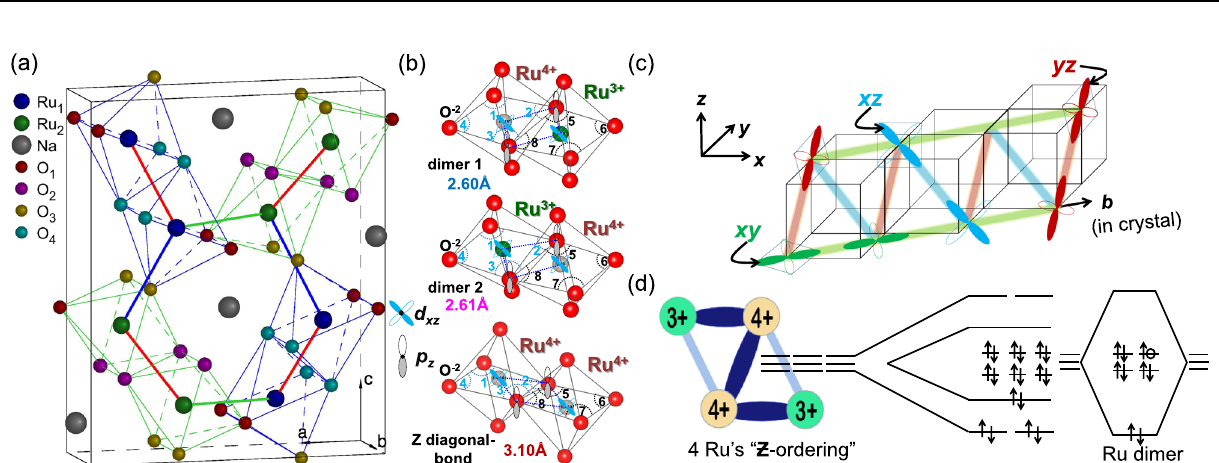
The summary of Ru valences from the bond-valence sum (BVS) calculations for different Ru sites in NaRu 2 O 4 at 300K shows different models below. The Model-3 looks consistent as per the observed dimerizationon the two-legzigzag ladder and ourdetailed LSDA + U calculations. Accordingly, we have used chargeson the respective Rusites inthe NaRu 2 O 4 crystalstructure (Figs.1 and 3a). TheGII is the reliability parameter as Global Instability Index. The average valence on Ru sites is 3.5 + . Ass. Val. assumed valence, Res. results.